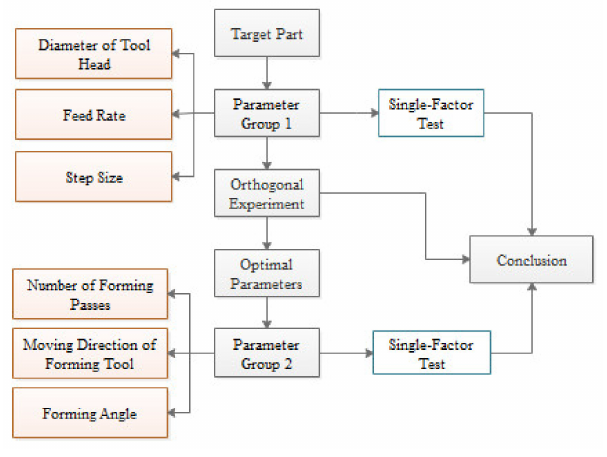
Figure 6. Design process.